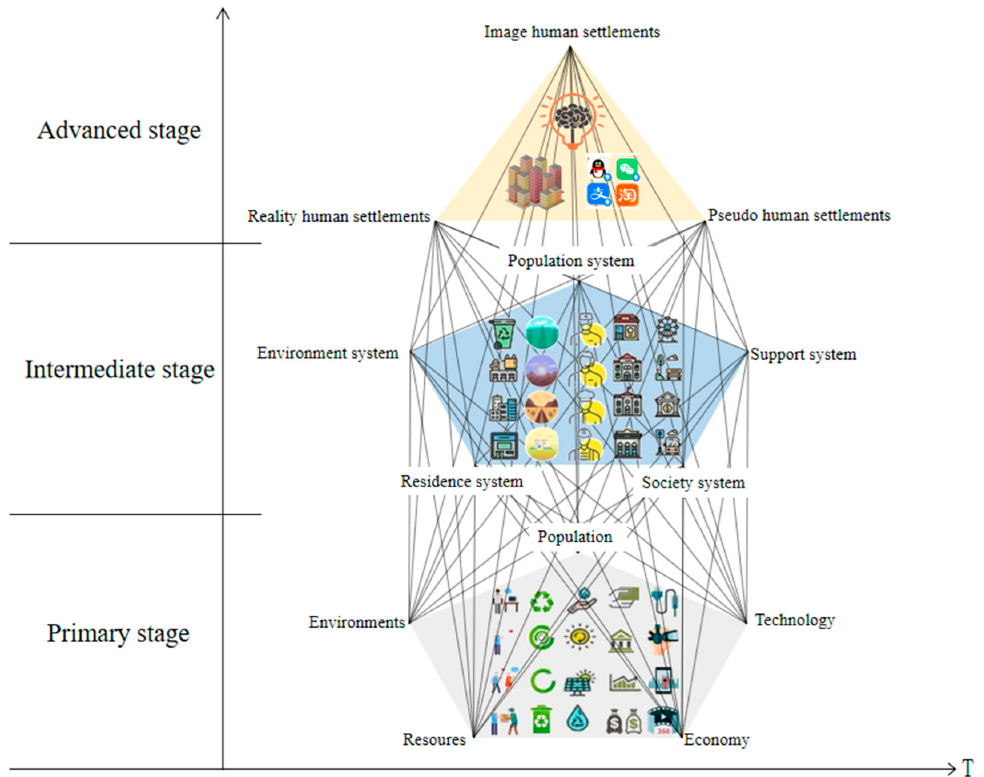
Figure 1. Frame diagram of theoretical connotation of “three states” coordinated development of high-quality human settlements.